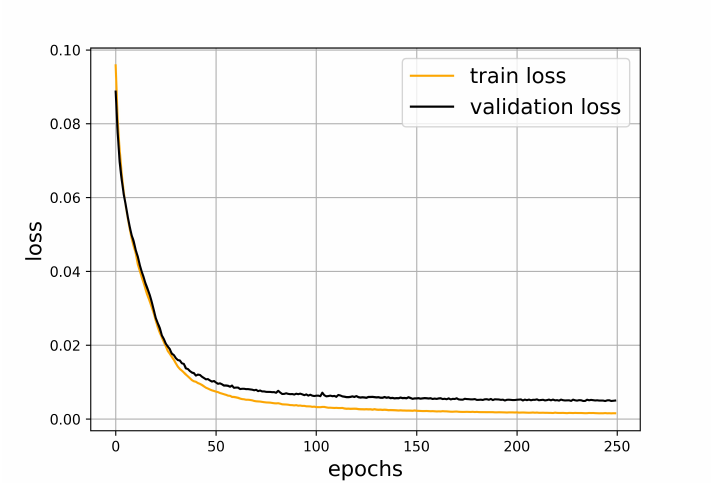
Figure 12. Train and validation loss for the unprocessed, raw simulation data with a locally connected layer.